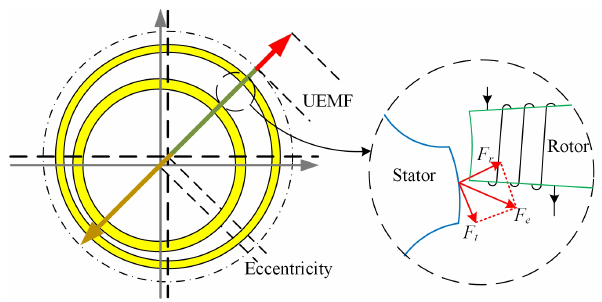
Figure 1. UEMF generated in a